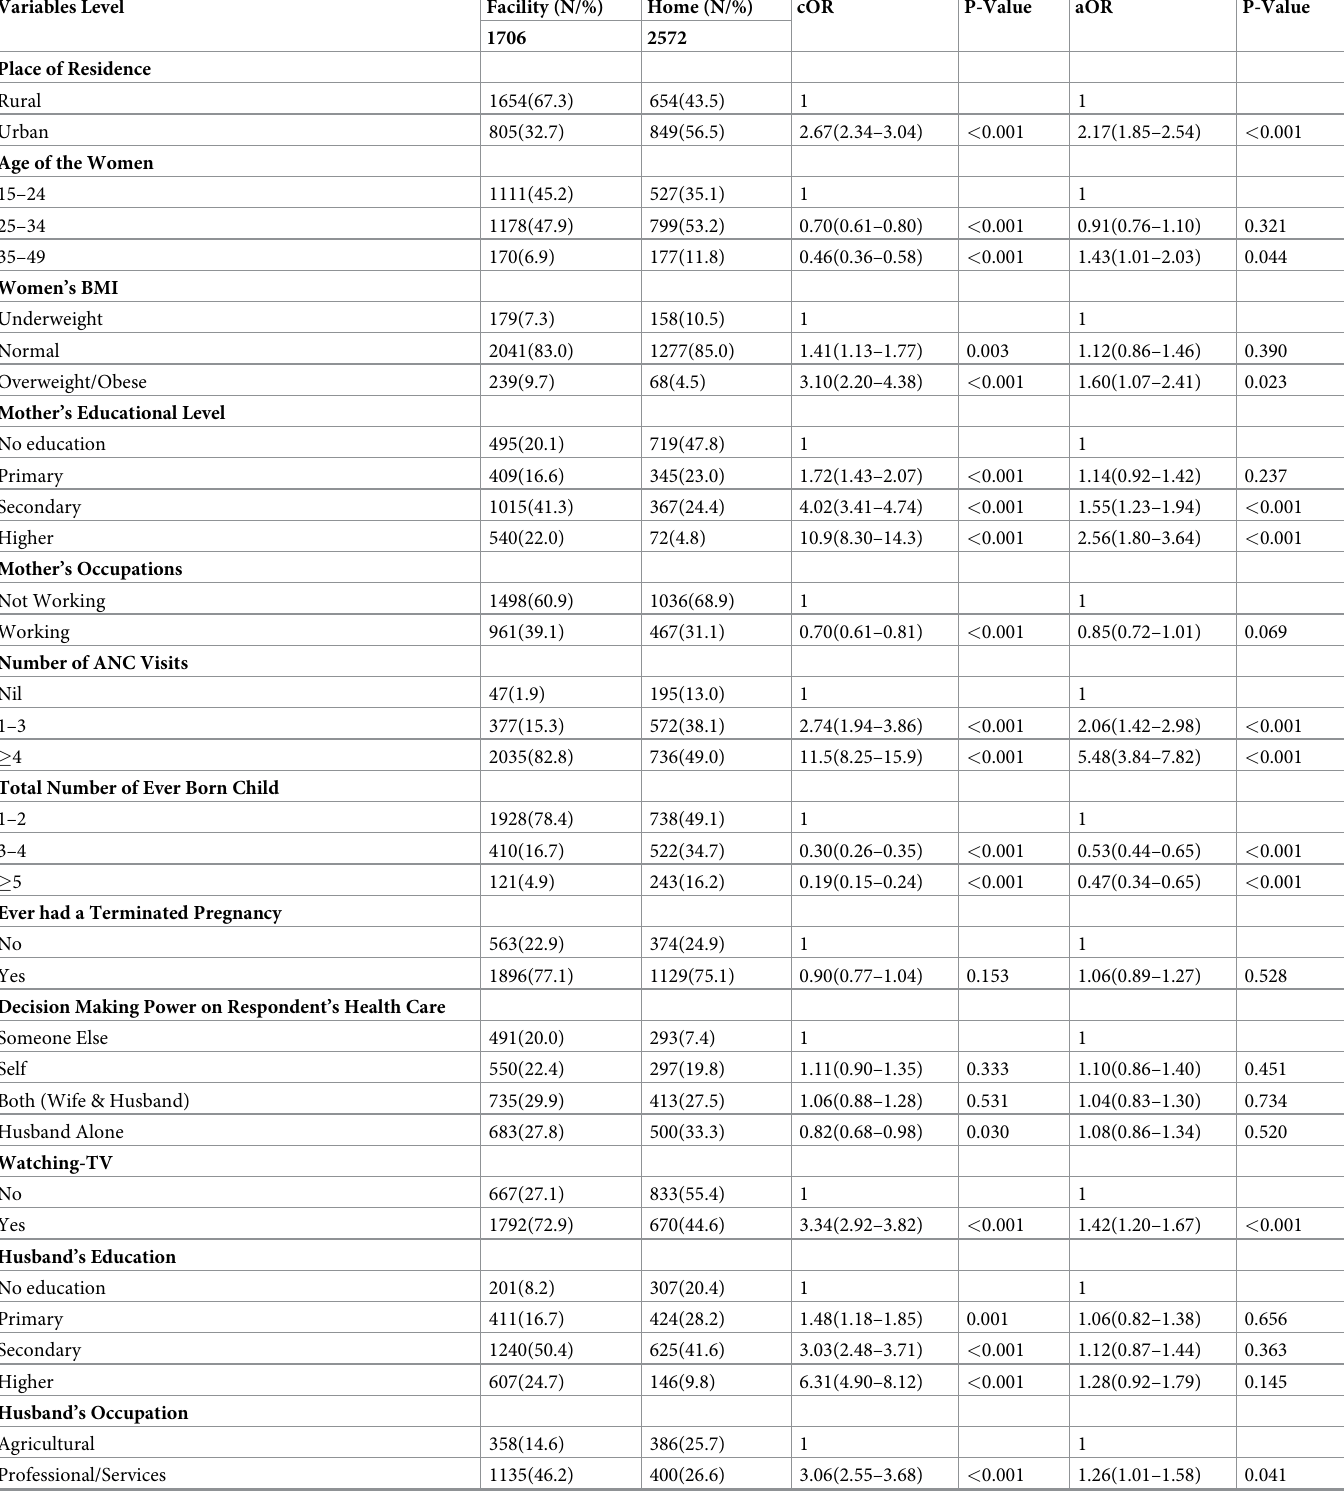
Table 4. Regression results factors associated with health facility delivery by background characteristics: NDHS